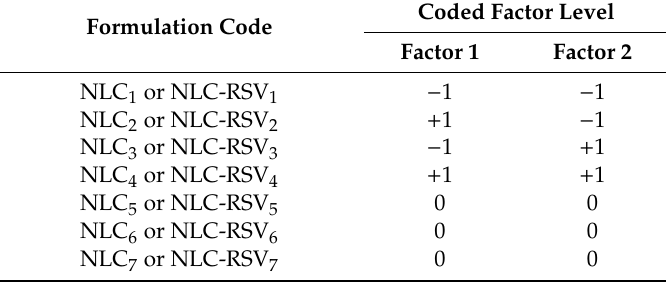
Table 2. A 2 2 full factorial experimental design layout. The formulation codes of NLC with resveratrol are named as NLC-RSV (number of the experiment) and the one without resveratrol as NLC (number of the experiment)